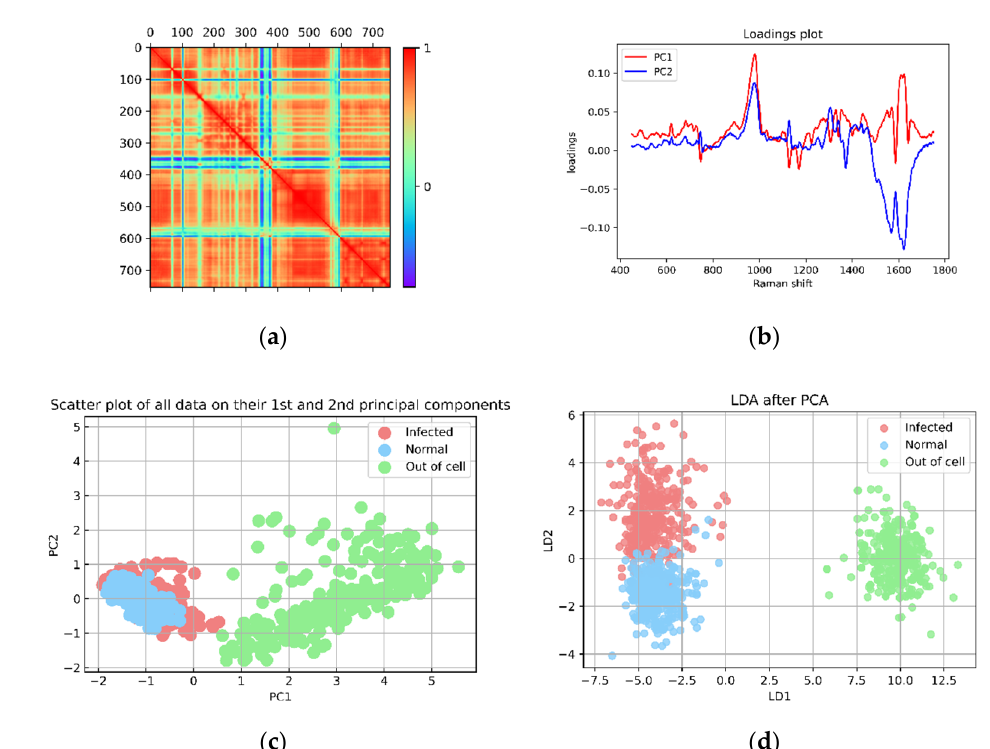
Figure 6. PCA-LDA results. ( a ) The covariance matrix of the PCA plot. ( b )The loading plot of PC1 and PC2 after PCA processing of 1175 Raman spectra (460 normal cells, 365 infected cells and 350 outside-the-cell spectra) by using 755 Raman shifts in the range of 450–1750 cm − 1 is presented. ( c ) The PCA result shows the PC1 and PC2 coordinate and 350 PC results from PCA are continually input to LDA processing. ( d ) The LDA result plots in LD1 and LD2. In ( c , d ): blue dots are designated as the normal cell transformed spectra, red dots represent the infected cell transformed spectra and green dots are the transformed spectra obtained from the outside-cell area.